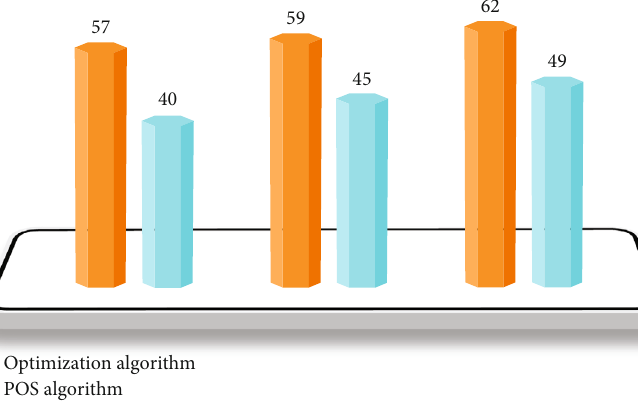
Figure 4: Comparison of the times of reaching the optimal